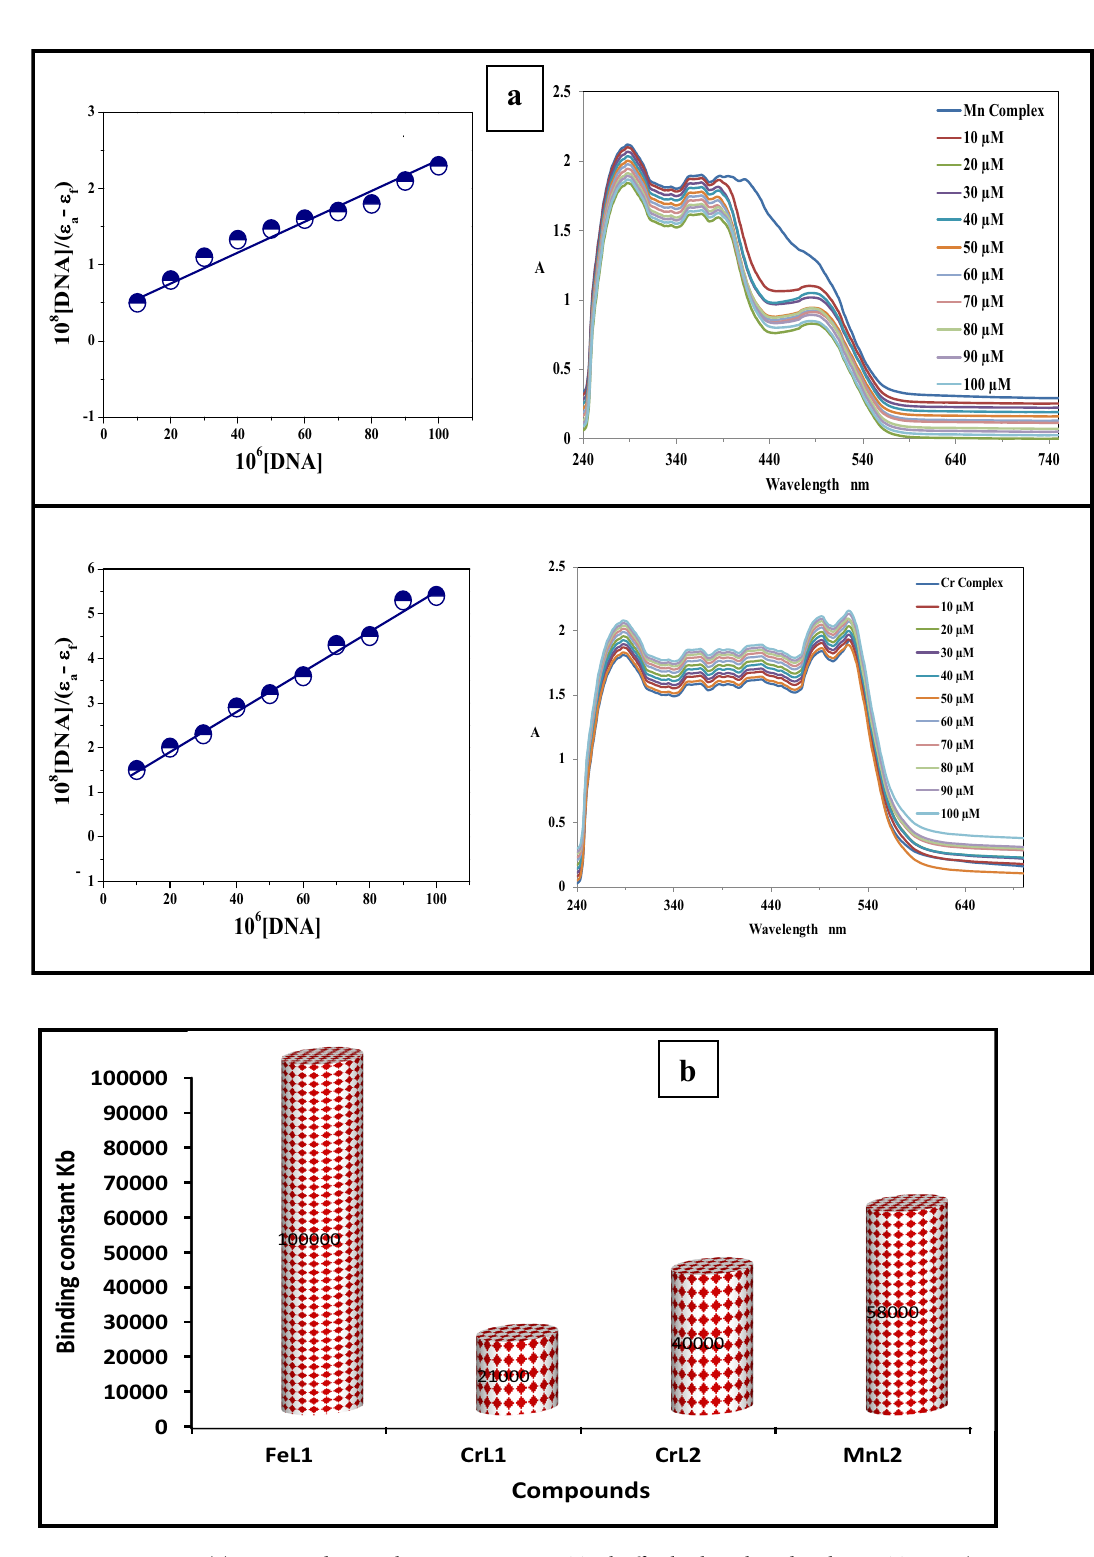
Figure 12. ( a ) MnL2 and CrL2 electronic spectra in Tris buffer, both with and without CT-DNA (pH 7.5, 298 K), the concentration of complex was 1 × 10 −3 M −1 and CT-DNA concentrations were 10–100 μM corresponding to the curves from 1 to 10, respectively. ( b ) FeL1, CrL1, CrL2, and MnL2’s binding constant Kb in mol −1 dm 3